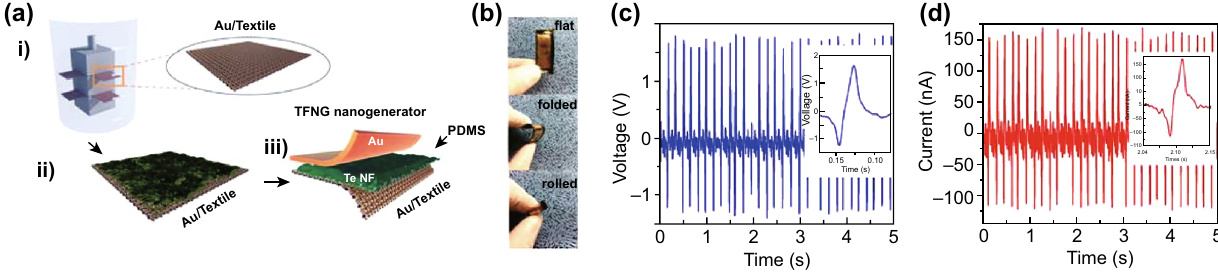
Fig. 14 a Schematic of the tellurene flexible nanogenerator (TFNG) device fabrication process. b Optical images of the TFNG devices in dif‑ ferent states: flat, folded, and rolled. c , d Measurements of the output voltage and current due to periodic bending and unbending behavior. The insets show a single bending–unbending event. Adapted with permission from [183]. Copyright 2016,